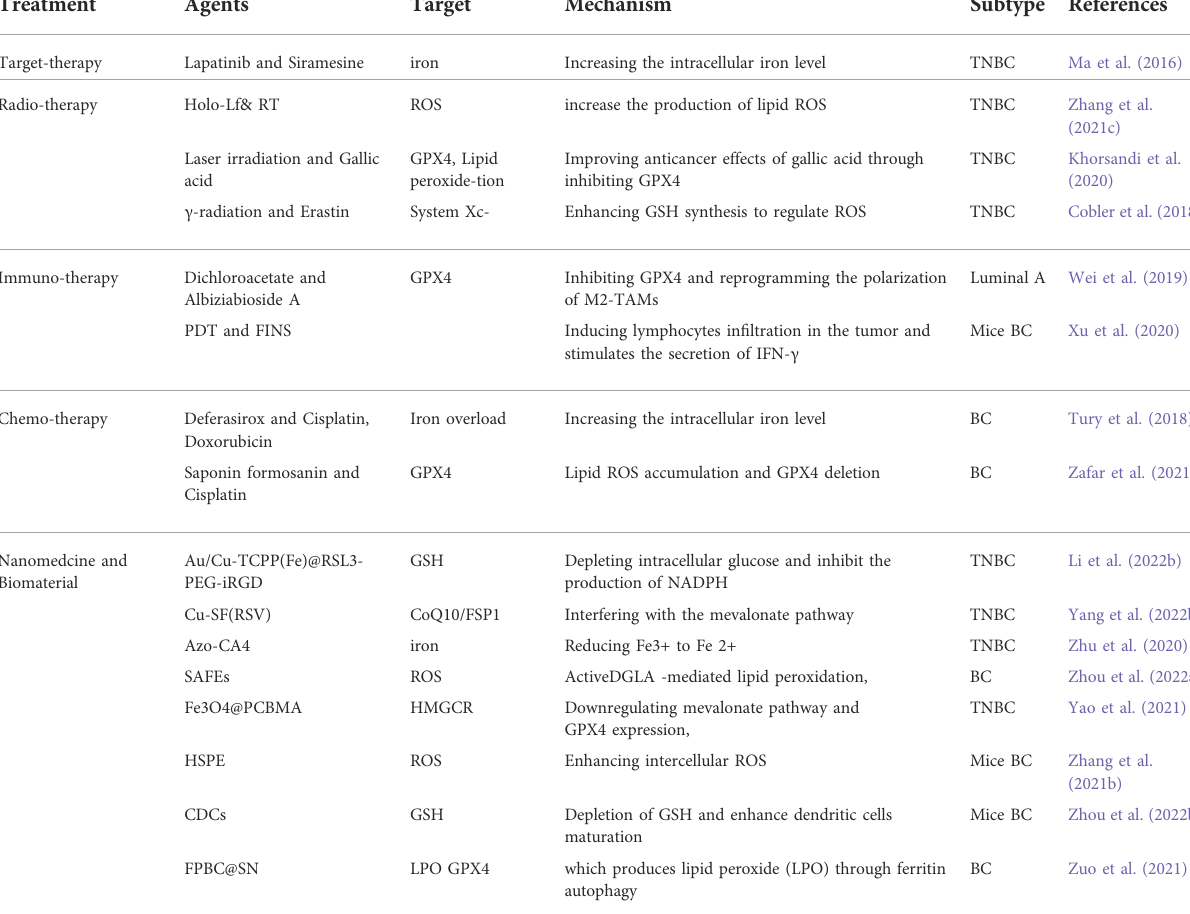
TABLE 2 The combination therapy with FINS in breast